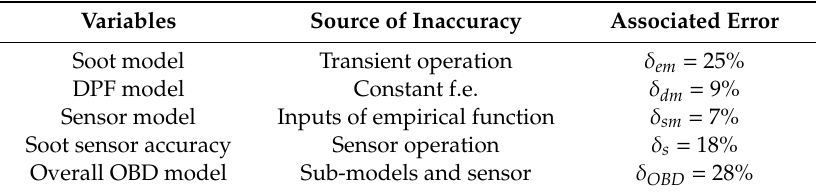
Table 8. OBD model variables and associated